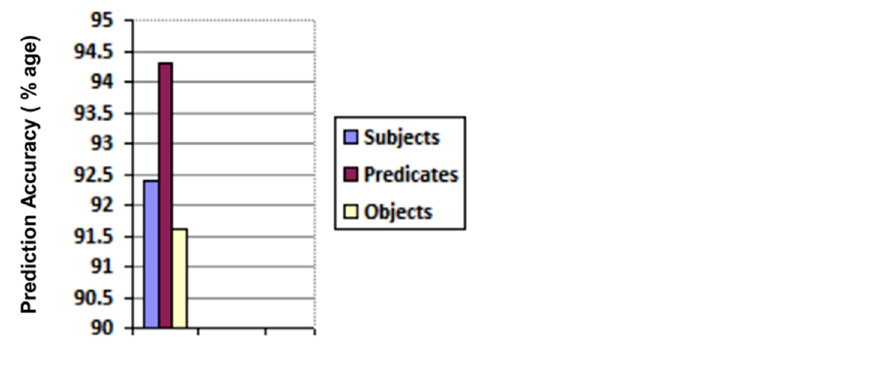
Figure 10. Prediction accuracy of subject/predicate/object in bi-LSTM returned triples.